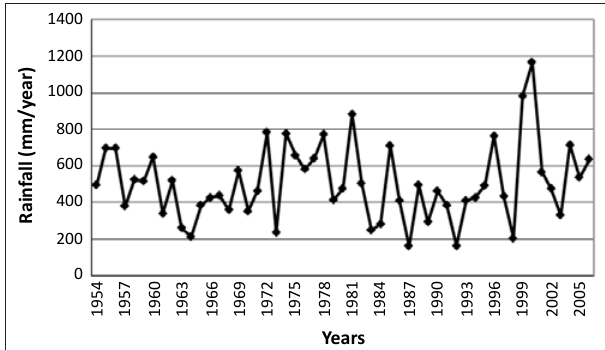
FIGURE 1: Mean annual rainfall in the Kruger National Park